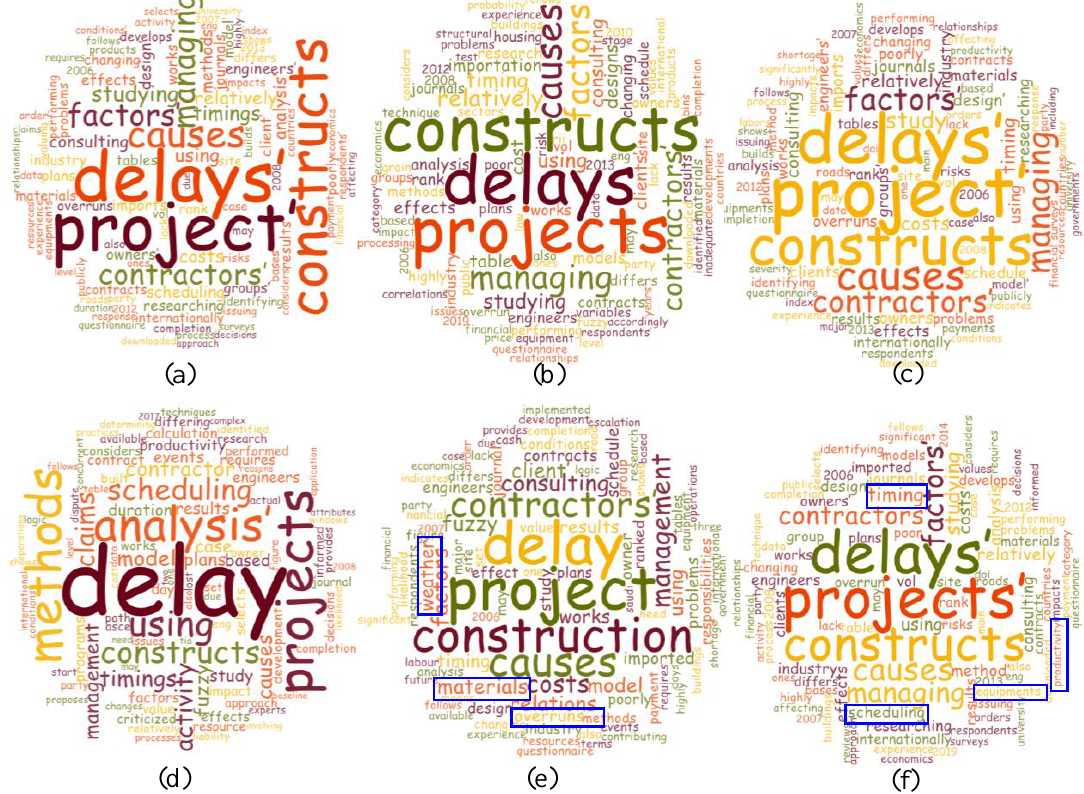
Figure 7. Word cloud created for different sources based on stemmed words. ( a ) All DEC dataset; ( b ) cluster 1; ( c ) cluster 2; ( d ) cluster 3; ( e ) published papers from 2009 to 2011; ( f ) published papers from 2016 to 2018. Table 3. Summary of selected articles of cluster 1 of delay investigations from 2015 to 2018. Focus of the